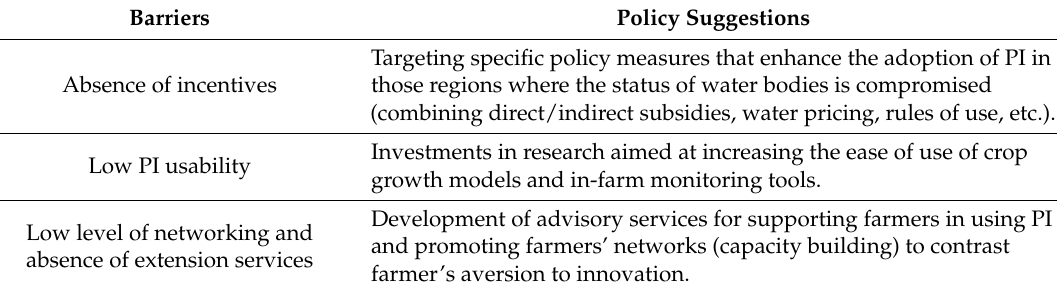
Table 2. Barriers and Policy suggestions influencing the adoption of